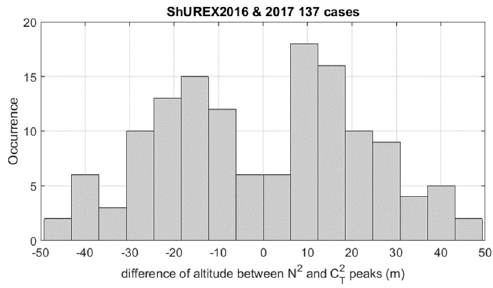
Figure 18. Histogram of difference of altitudes between selected peaks of 𝑁 (cid:2870) and 𝐶 (cid:3021)(cid:2870)